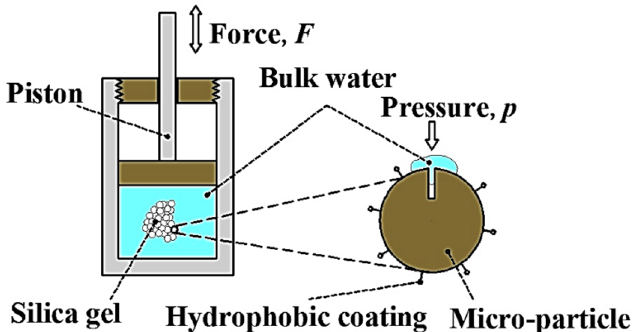
Figure 6. Structural sketch of the CD.